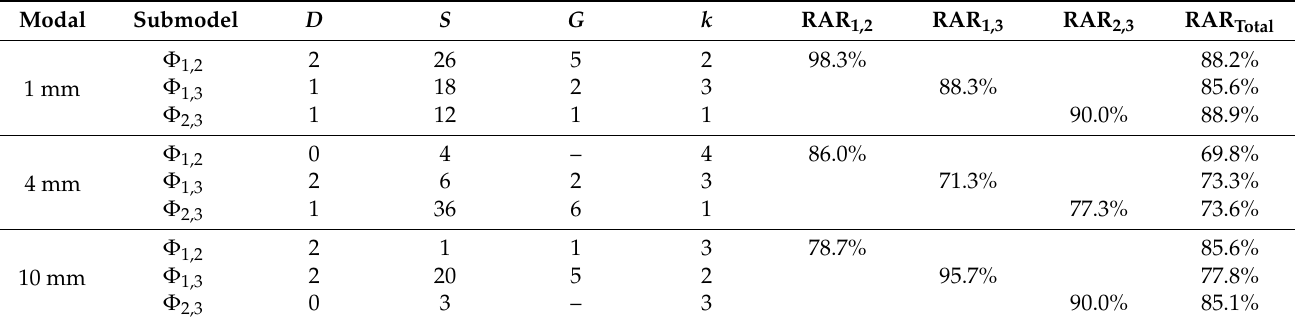
Table 5. Modeling discrimination effect of the 2-category priority’s compensation models of three measurement modals processed by optimal NDF parameters.